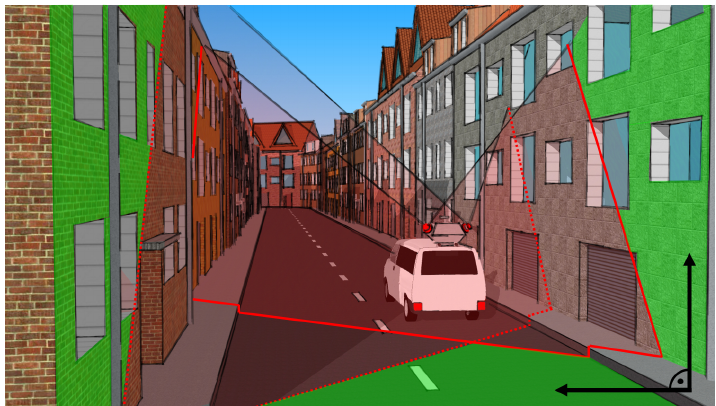
Figure 13. Exemplary illustration of a scenario for information-based georeferencing of a kinematic MSS (white vehicle) with classified building facades and road surface (green), as well as their geometric relation